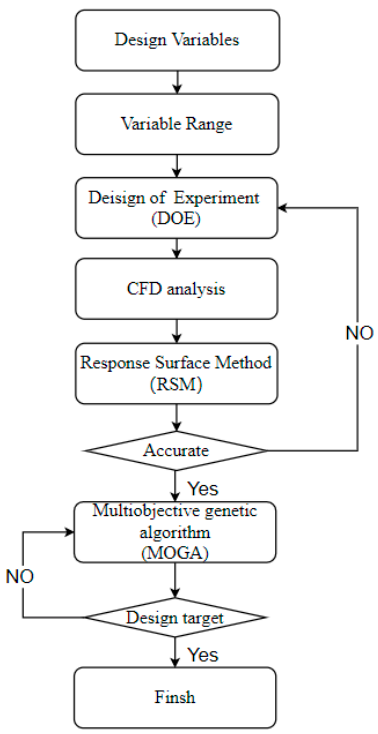
Figure 5. The flow chart of the parametric design of the BSG.